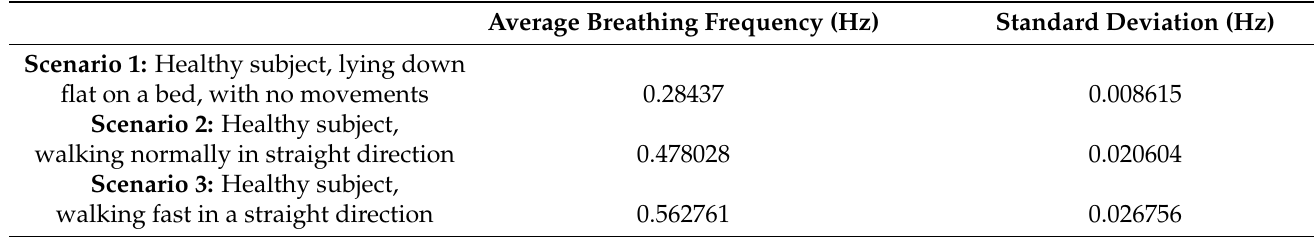
Table 1. Average breathing frequency of a healthy subject at different